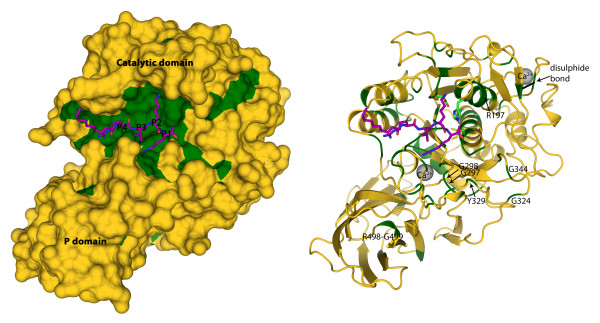
Conservation of the PCSK catalytic domain. The 3D-structure of mouse FURIN is shown as surface (left) and cartoon (right) presentation and the bound inhibitor as purple stick model. Amino acids identical in >95% of the 152 related PCSK sequences are marked with green color, indicating highly conserved active site. Sequences that were used for the analysis are available in the Additional File 1. Some of the conserved residues are labeled using the FURIN numbering.